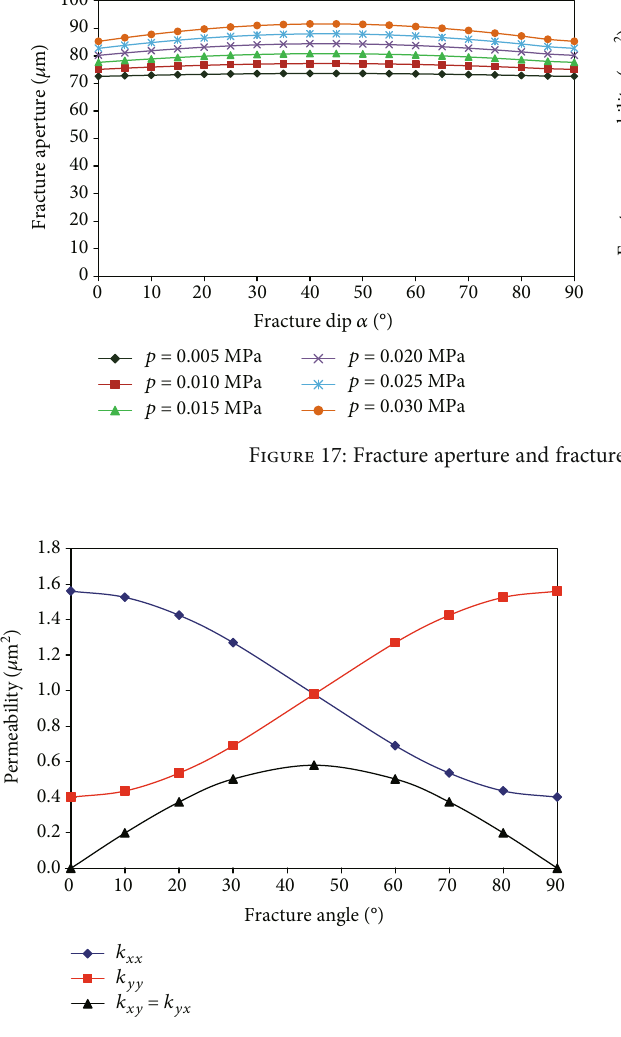
Figure 18: Variation of the permeability tensor with fracture direction.